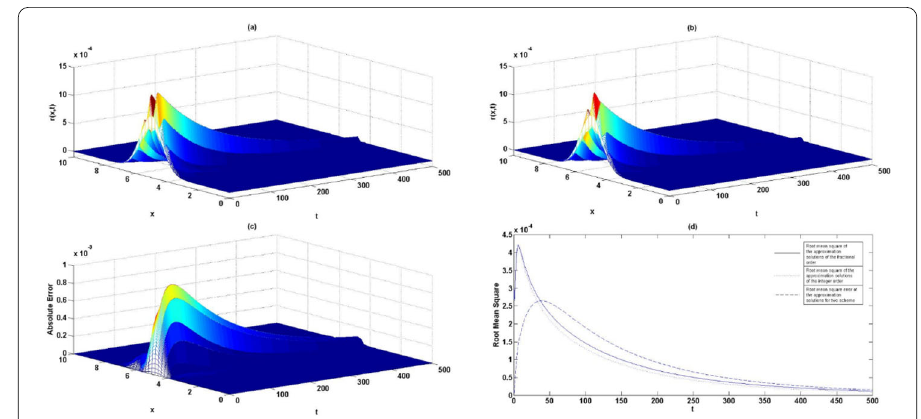
Figure 3 ( a ) The approximation solution of the fractional order differential equation. ( b ) The approximation solution of the integer order differential equation. ( c ) The absolute error between the approximation solutions of the fractional order with the integer order differential equation. ( d ) The root mean square error between the approximation solutions of the fractional order with the integer order differential equation